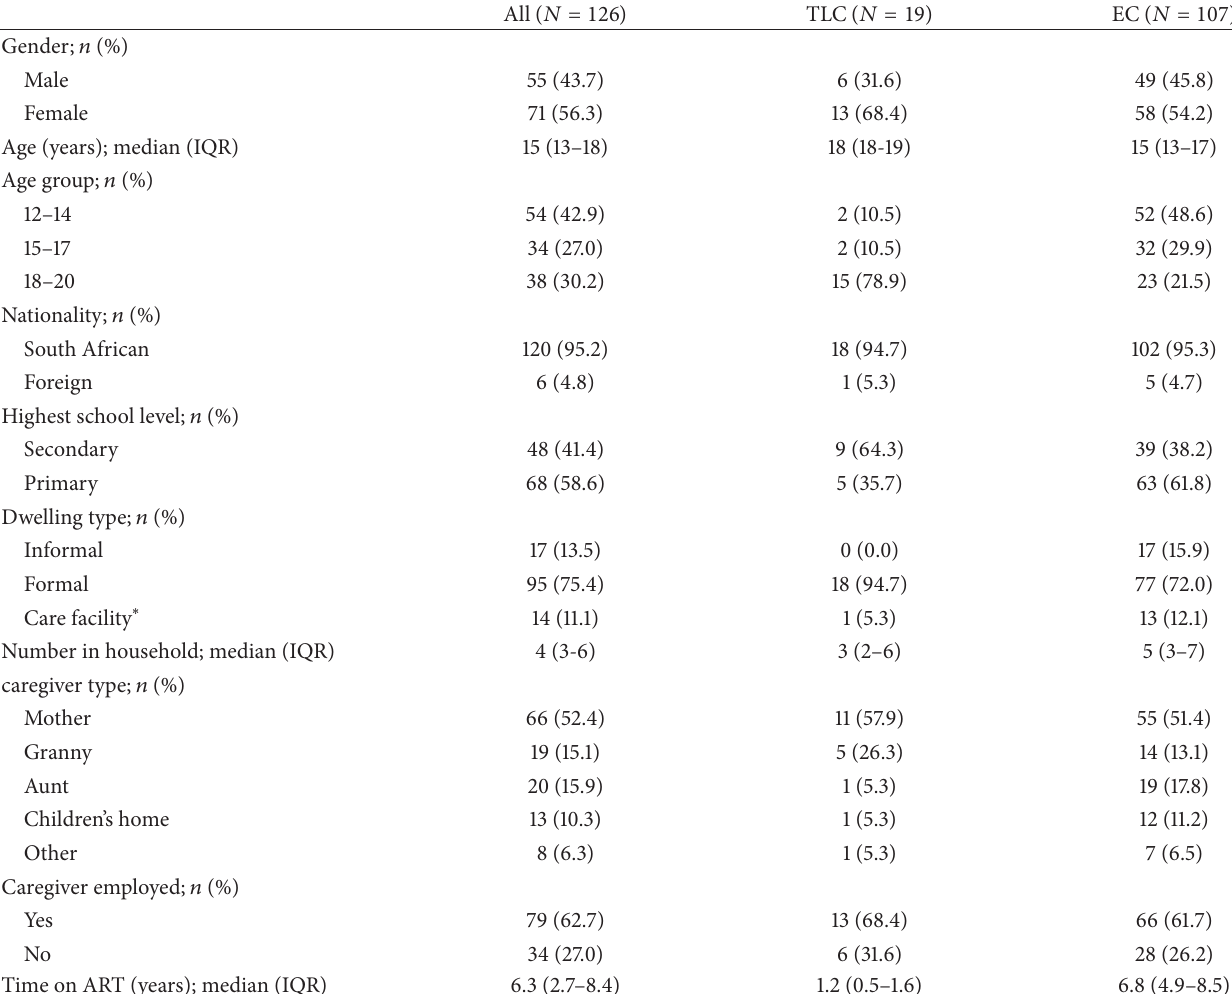
Table 1: Demographics at study